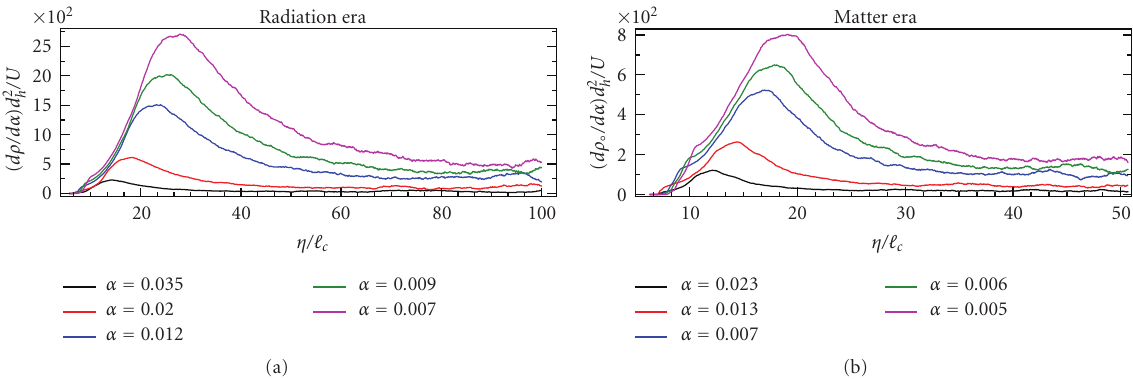
Figure 8: Evolution of the energy density distribution of αd h -sized loops as a function of the conformal time in the radiation and matter era. After an overproduction regime, the energy density distribution scales as 1 /d 2